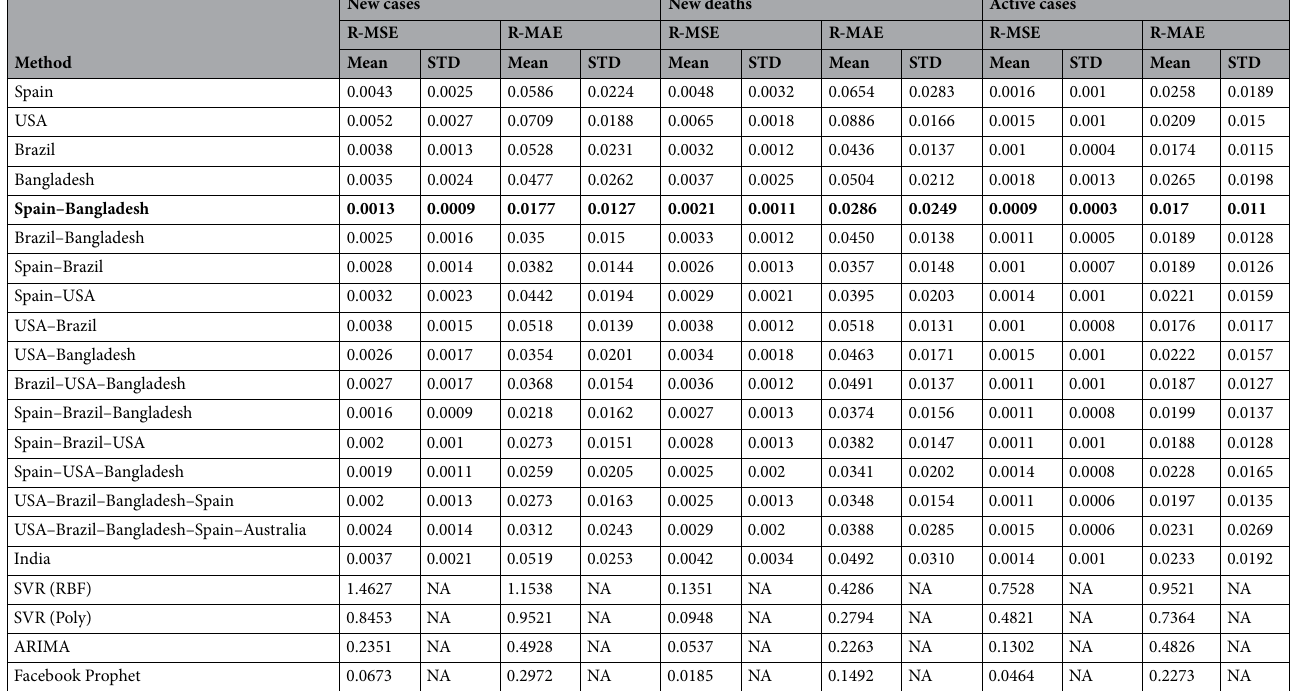
Table 2. Comparison of results i.e. Mean and Standard Deviation (STD) of 20 runs, from all possible combinations of four countries considered in this study. The GRU models have been fine-tuned on Indian data. Results are also shown for SVR, ARIMA and Facebook Prophet models. Best results are in